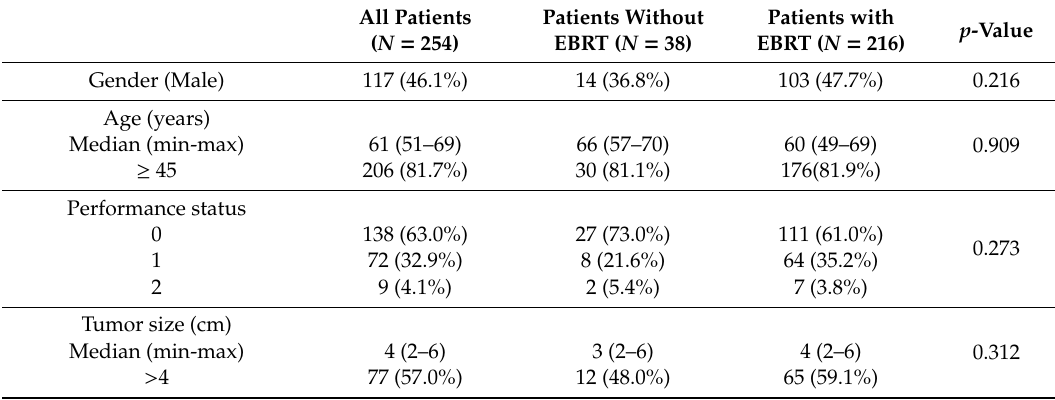
Table 1. Patient and tumor characteristics and initial treatment for whole population and according to external beam